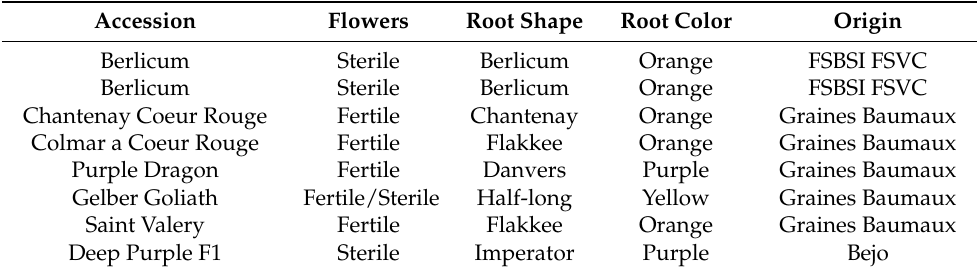
Table 1. Carrot genotypes selected for the